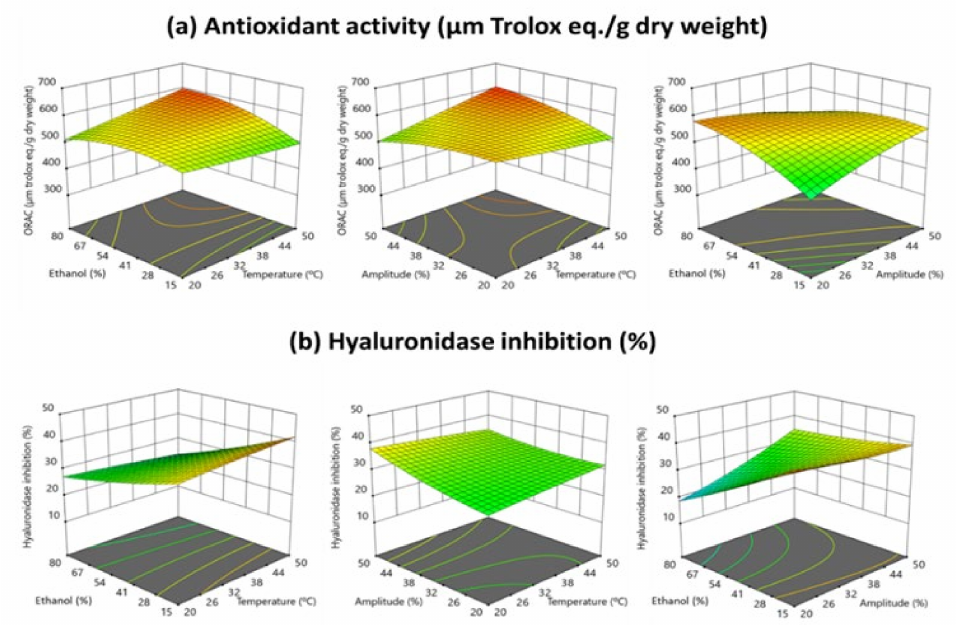
Figure 6. Response surface graph illustrating the quadratic effect of the three independent variables on ( a ) antioxidant activity by ORAC ( µ mol Trolox eq./g dry weight) ( b ) anti-inflammatory activity by hyaluronidase inhibition (%) of the extracts obtained at 5 min UAE